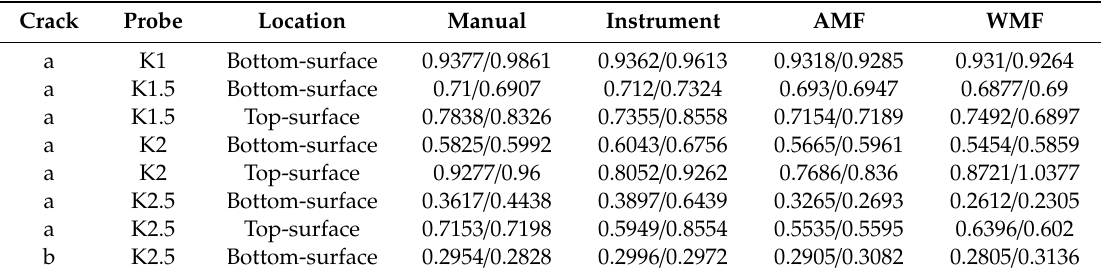
Table 9. The standard deviation of the results of the Monte Carlo simulations and experiments, (simulations / experiments),